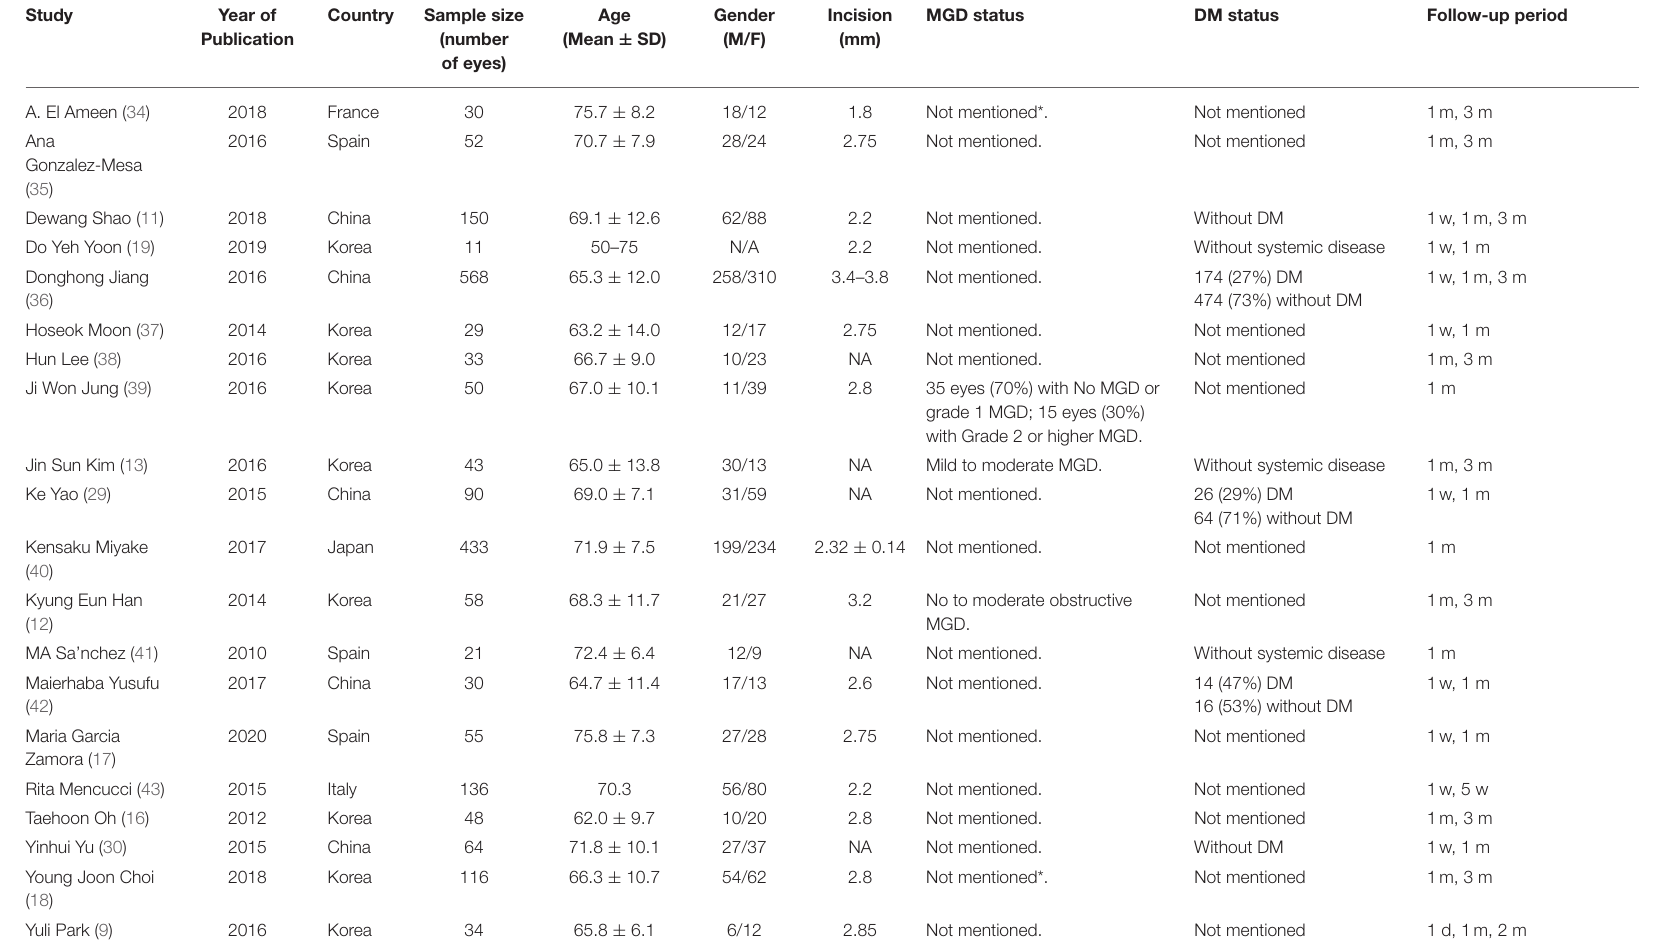
TABLE 1 | Characteristics of the included